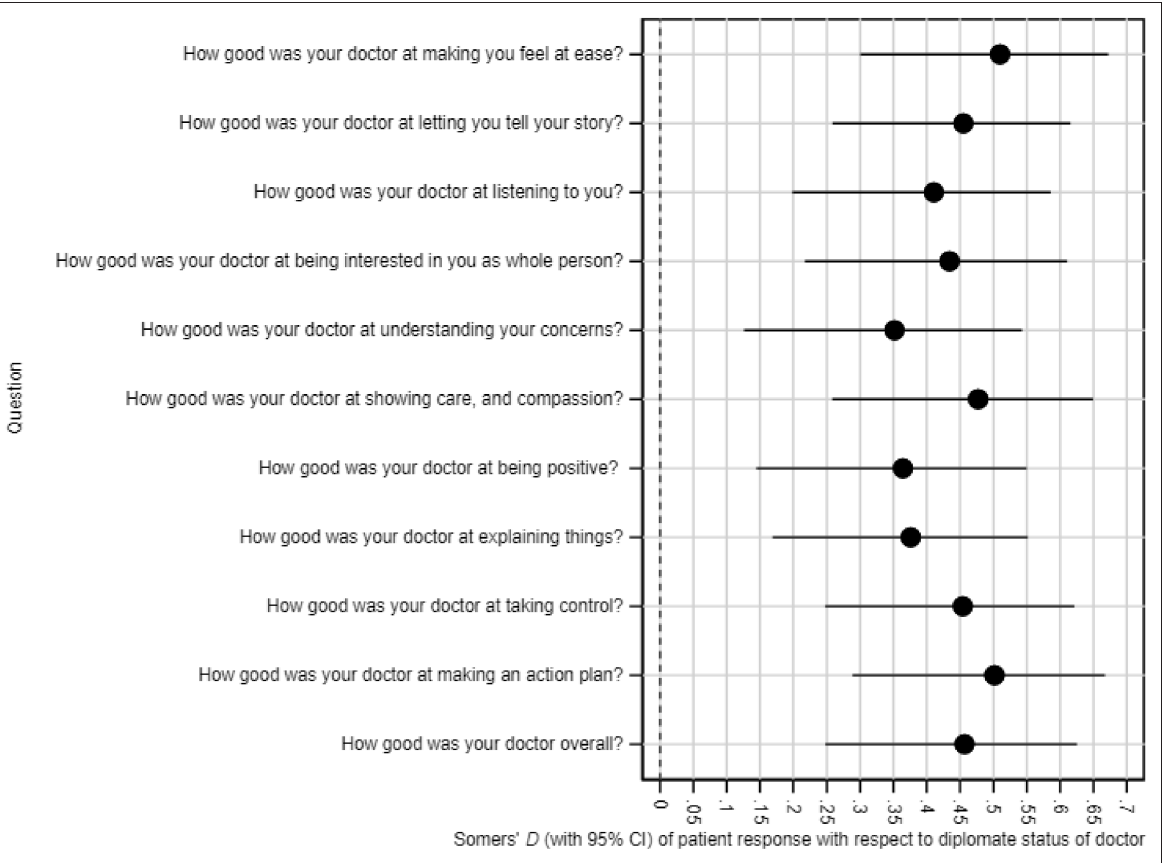
Figure 3 Confidence interval plot. Somers’ D of patient response with respect to diplomate status of